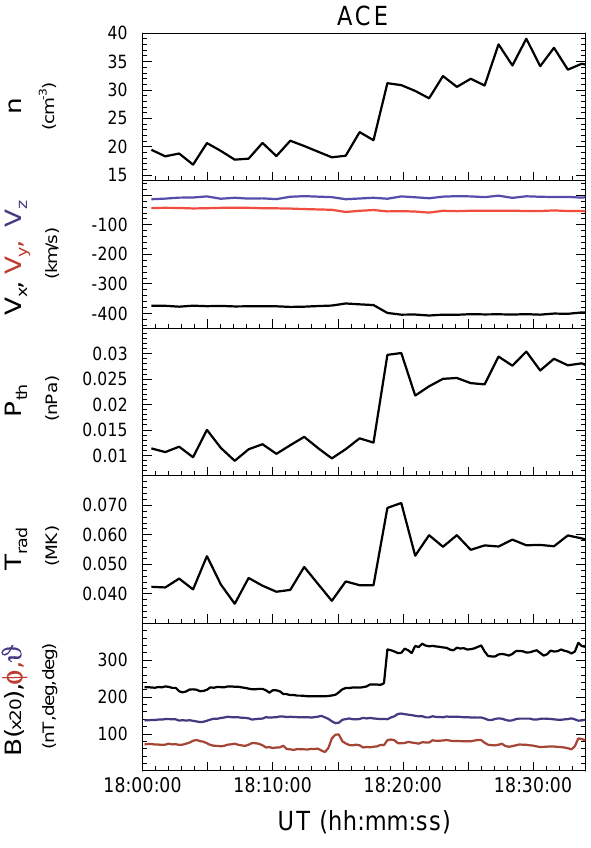
Fig. 3. The perpendicular interplanetary shock, causing the magne- tosheath perturbation of Fig. 1, as seen by ACE/SWEPAM (plasma analyzer) and ACE/MAG (magnetometer) instruments. The time resolutions of plasma and magnetic field L2 verified data are 64s and 16s, respectively. The magnetic field is reported in GSE polar coordinates. T rad is the proton radial